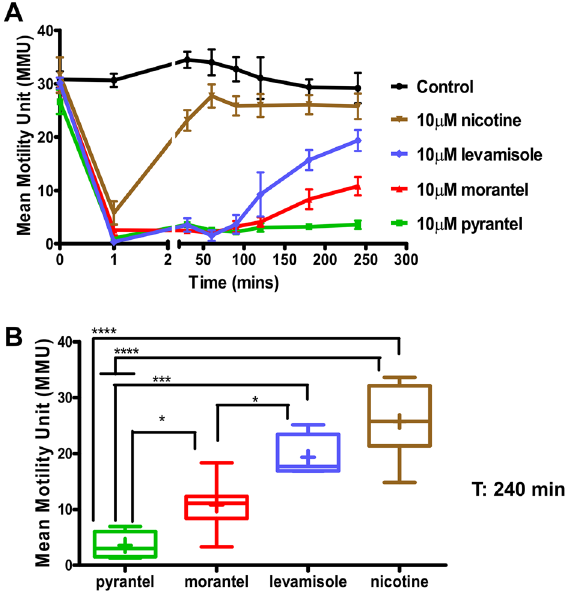
Figure 3. Adult female B. malayi possess multiple nAChR subtypes that vary in sensitivity to various nAChR agonists. ( A ) Concentration- and time-dependent analysis of the inhibitory effects of nicotine (brown), levamisole (blue), morantel (red), and pyrantel (green) on worm motility. Worms were treated at a concentration of 10 µM for each drug individually. N = 7 worms per concentration over two biological replicate studies. ( B ) Bar chart (mean ± SEM) showing the mean motility of B. malayi after 4 h (240 min) post agonists treatment. The efficacy in inhibition of motility at 240 min was as follows: 10 µM pyrantel > 10 µM morantel > 10 µM levamisole > 10 µM nicotine; n = 7 worms per concentration over two biological replicate studies. One-way ANOVA was performed for statistical analysis and p < 0.05 (*), p < 0.001 (***) and p < 0.0001 (****) were considered statistically